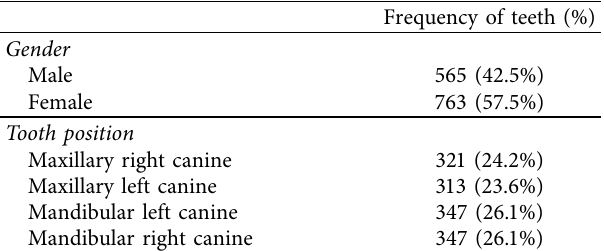
Table 1: The frequency of teeth according to gender and tooth